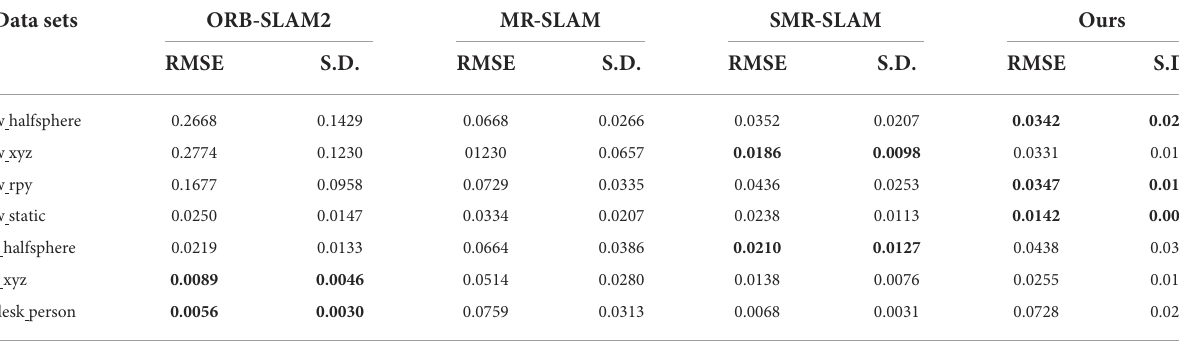
TABLE 2 Ate in meters for the experiments using ORB-SLAM2, MR-SLAM, SMR-SLAM, and Ours. Data sets